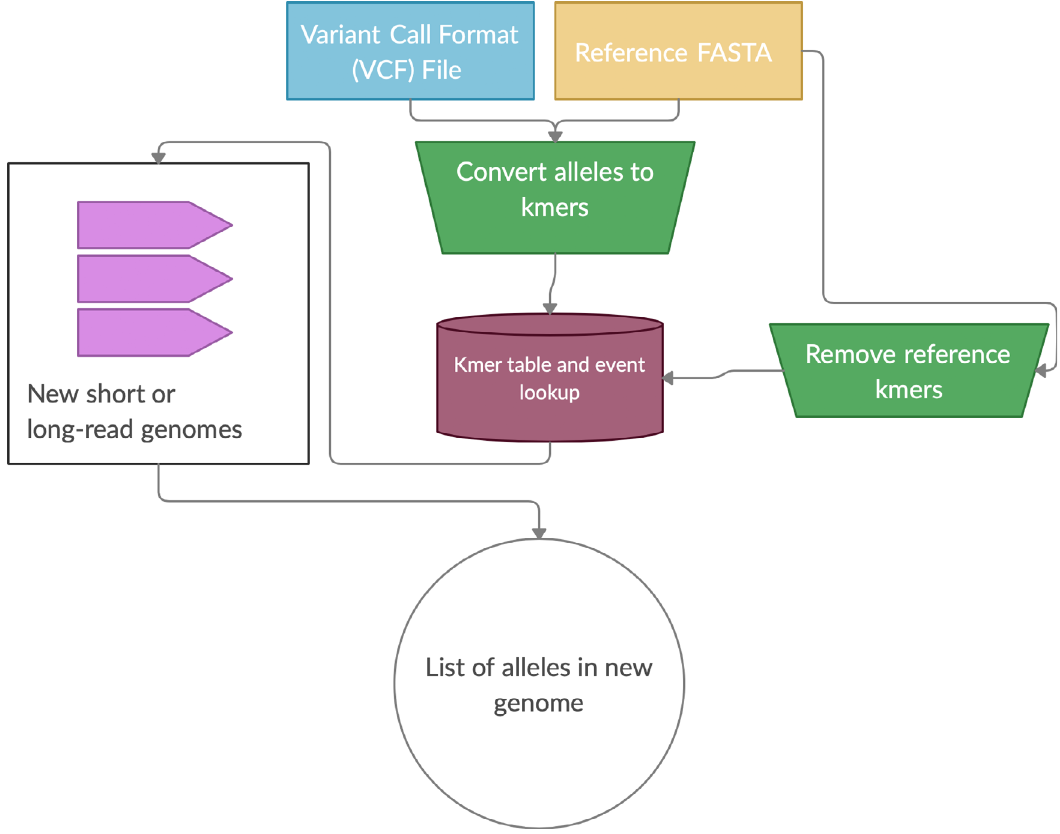
Figure 1. Overview of the NibbleSV software package workflow. Overview of NibbleSV workflow that utilises an input reference genome and file containing variant calls to generate a list of genotyped alleles using a kmer based